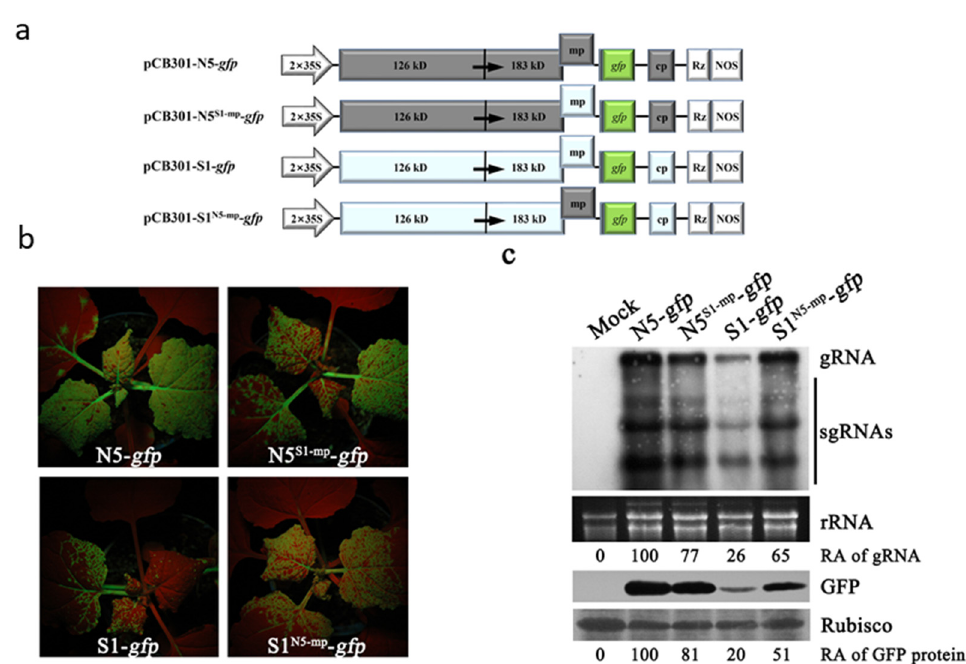
Figure 2. N5 MP increased viral accumulations in Nicotiana benthamiana. ( a ) Schematic diagrams of ToMV constructs harboring the coding sequence of green fluorescent protein (GFP). ( b ) Appearance of green fluorescence on the plants inoculated with N5- gfp , S1- gfp , or their MP recombinants under a long wavelength UV illuminator at 8 dpi. ( c ) Northern blot and immune blot analyses of viral RNAs and GFP proteins in upper systemic leaves, respectively. Genomic RNAs and subgenomic RNAs of these viruses were indicated with gRNA and sgRNA, respectively, to the right. Relative accumulation levels of gRNA and GFP protein are shown below. Ethidium bromide-stained ribosomal RNAs (rRNAs) were used as a loading indicator. The large subunit of Rubisco stained by Ponceau S was used to assess the relative amounts of protein samples loaded.